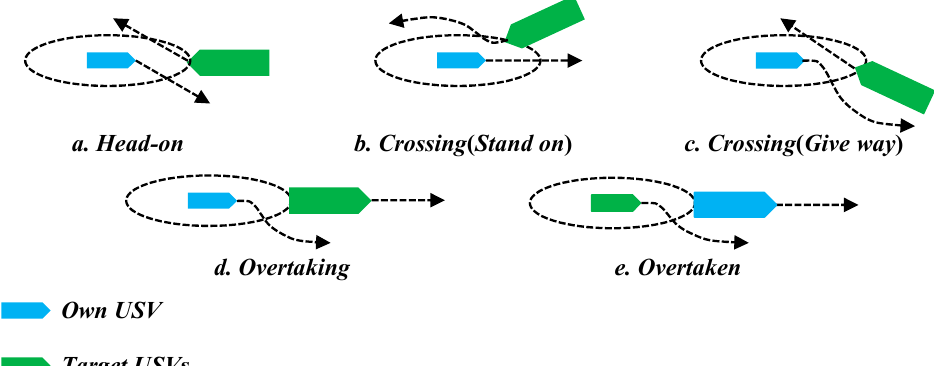
Figure 1. Typical encounter situations as described in the International Regulations for Preventing Collisions at Sea (COLREGs): ( a ) Head-on; ( b ) Crossing (own USV is the stand-on vessel); ( c ) Crossing (own USV is the give-way vessel); ( d ) Overtaking; ( e )